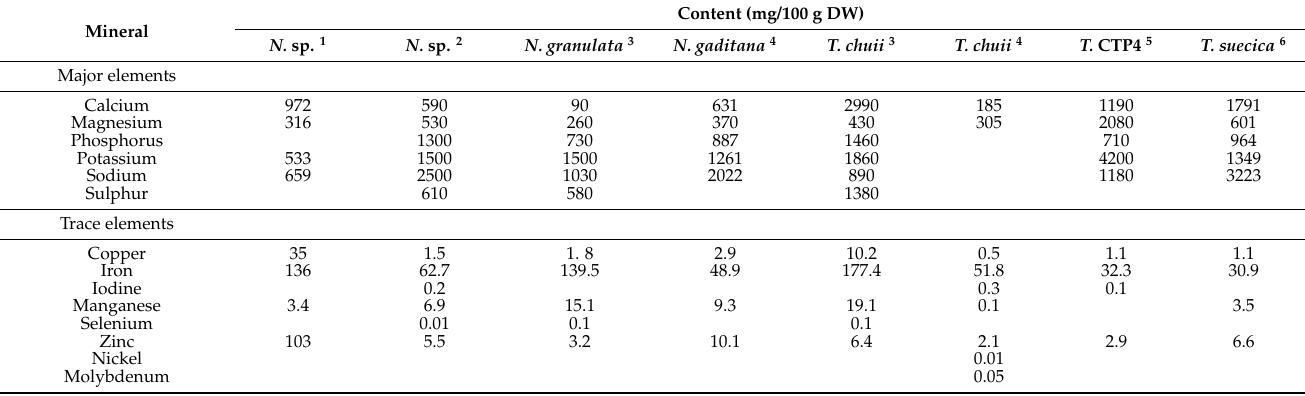
Table 3. Minerals (major and trace elements, expressed as mg/100 g of dry weight, DW) composition of Nannochloropsis sp. and Tetraselmis sp. microalgae.